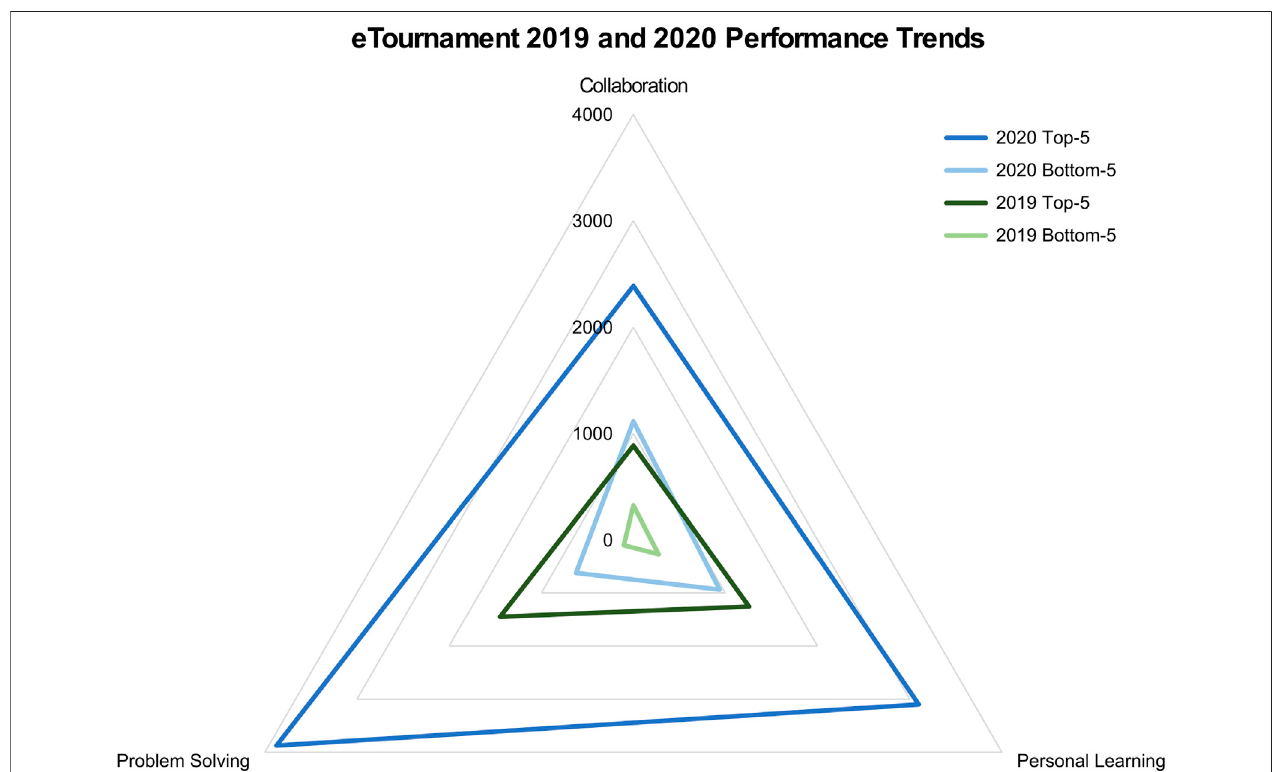
FIGURE 2 | Performance trends of the top-5 and bottom-5 teams of both